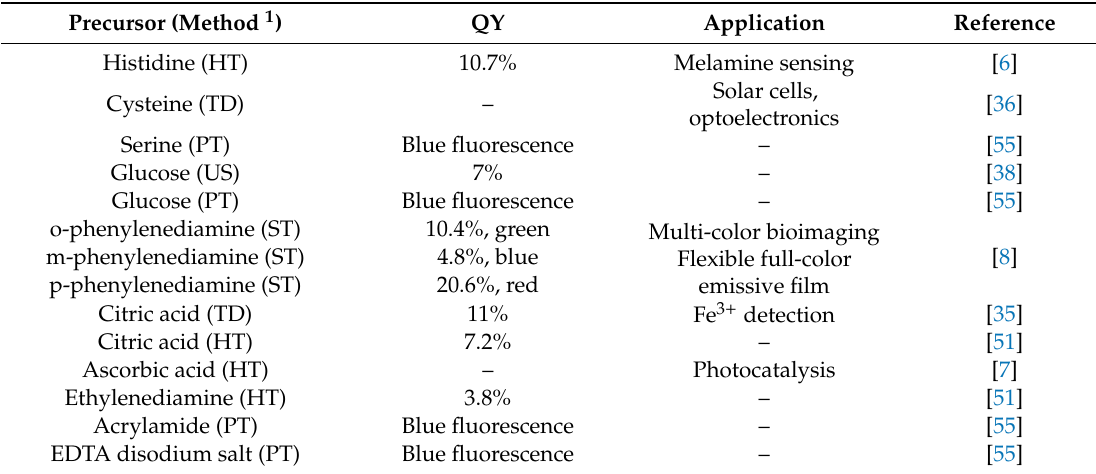
Table 2. Small molecule sole precursors for CD